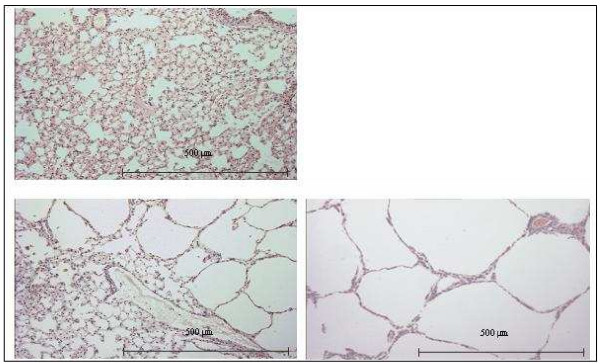
Representative photomicrographs showing morphology of lungs treated with phosphate buffered salt (normal lung morphology; upper panel), single elastase application (lower panel on the left), and repetitive elastase instillations over a period of 5 weeks (pronounced emphysematous changes; lower panel on the right).